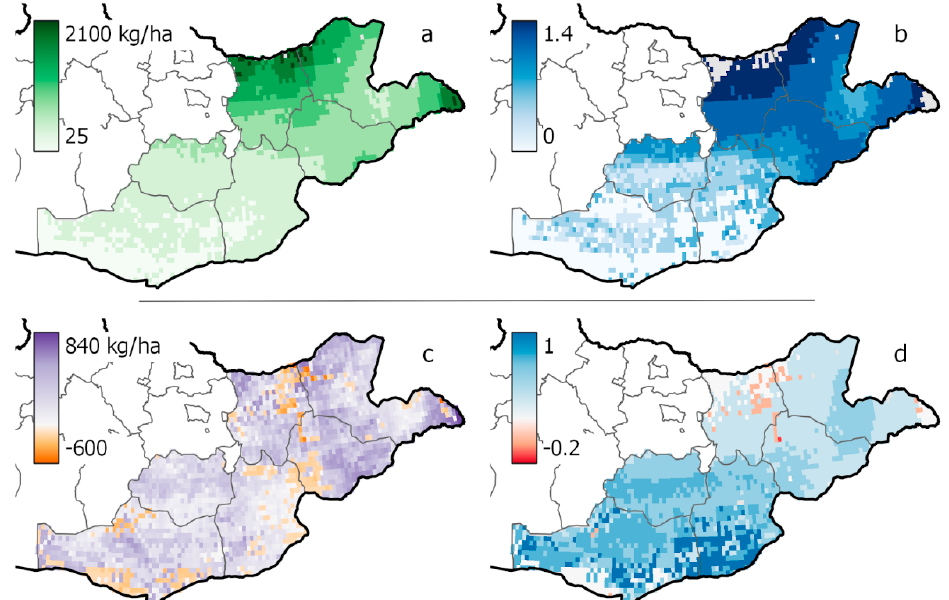
Figure A6. Current peak biomass ( a ) and animal diet sufficiency ( b ) for the Gobi-Steppe ecoregion as modeled by RPM when driven by current climate and livestock density. Bottom panels show the absolute value change in peak biomass ( c ) and diet sufficiency ( d ) between RPM simulations driven by future climate conditions as compared to current.